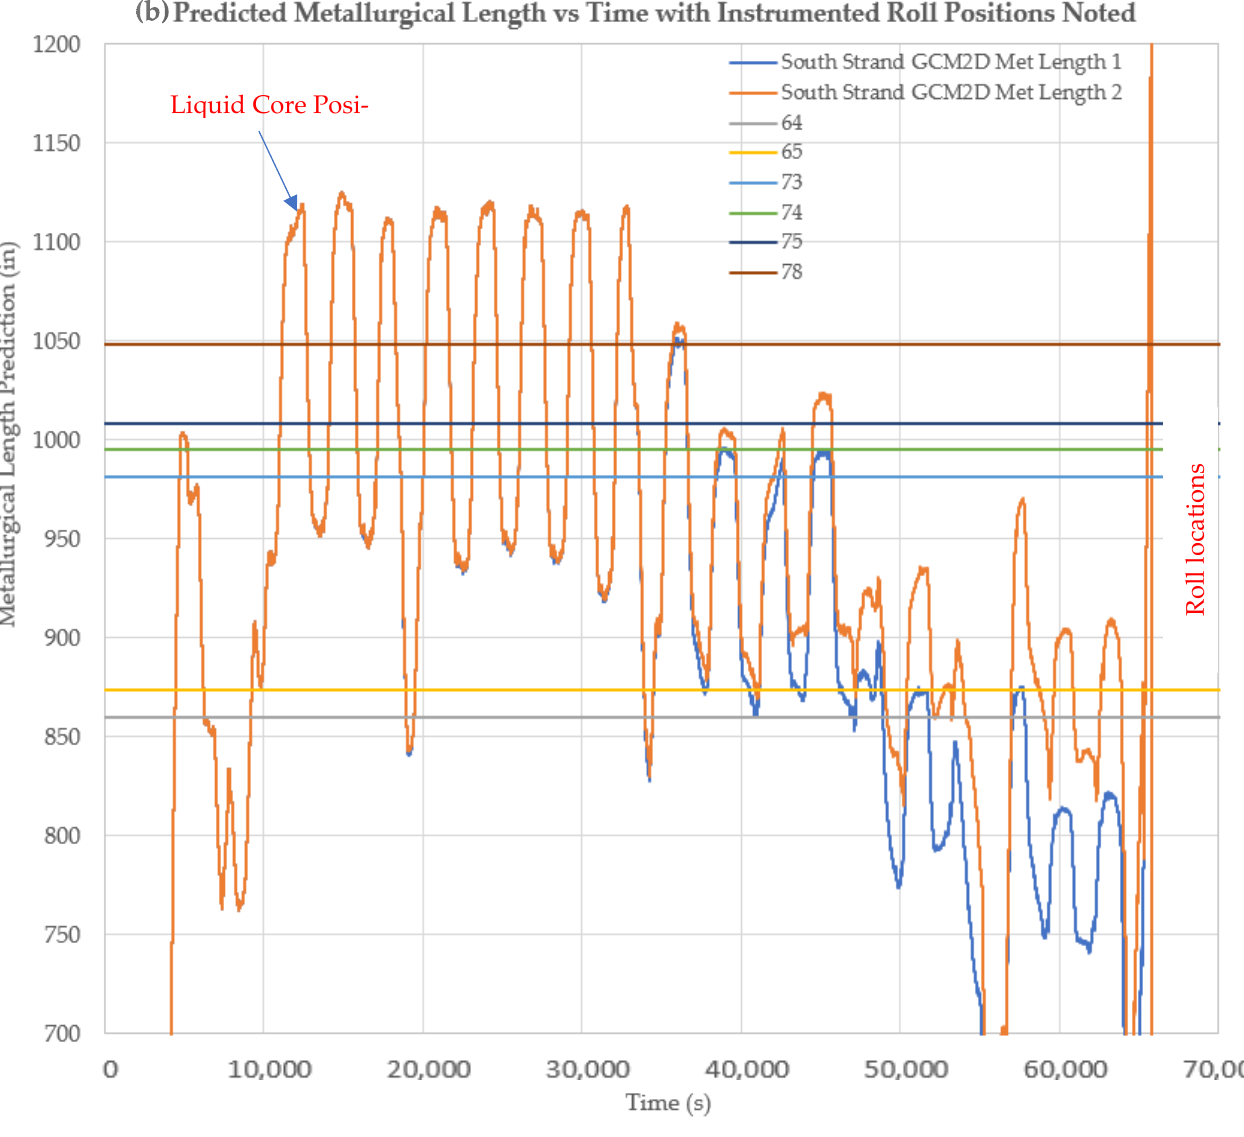
Figure 19. ( a ) Cast speed and mold width vs. time. ( b ) Cast speed, width, and liquid core position predictions from two models with instrumented roll positions superimposed for a 20-heat cast sequence.